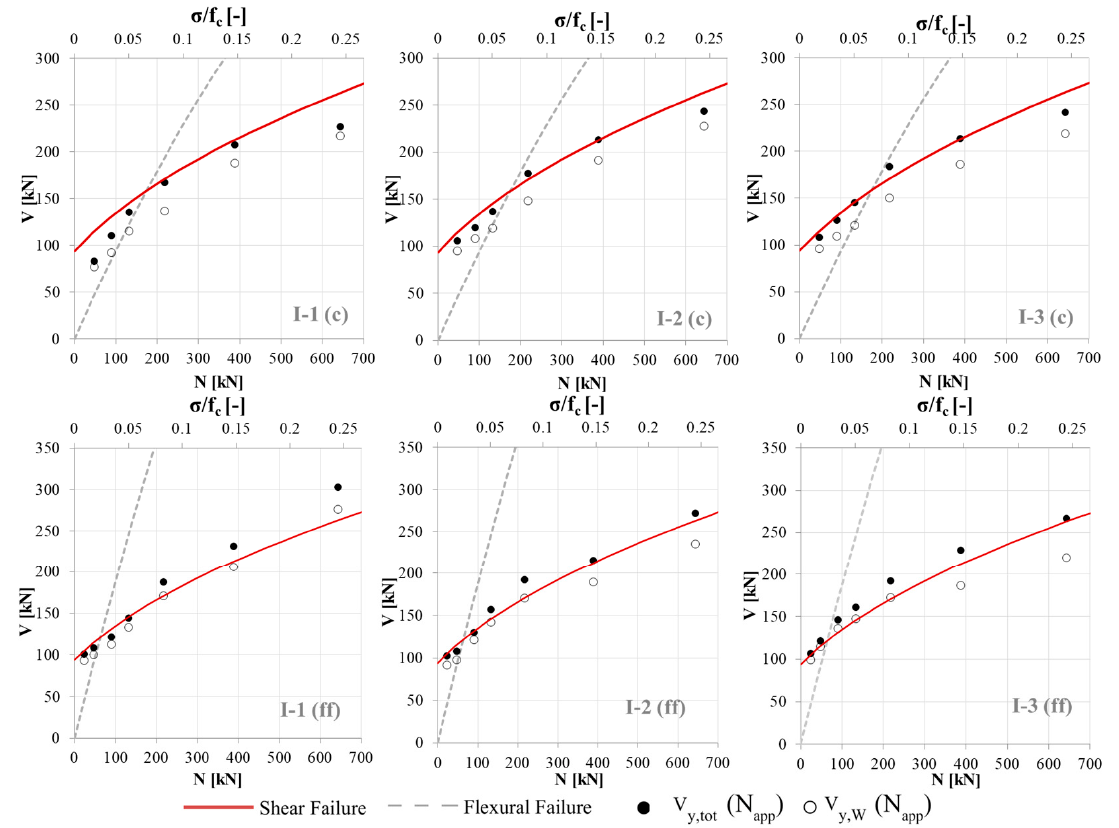
Figure 7. Failure domain of the web panel and results of the numerical FE analyses. Results refer to each one of the examined configurations (“c” = cantilever scheme; “ff” = fixed-fixed scheme); the values of V y,tot and V y,W correspond to the axial force N app .